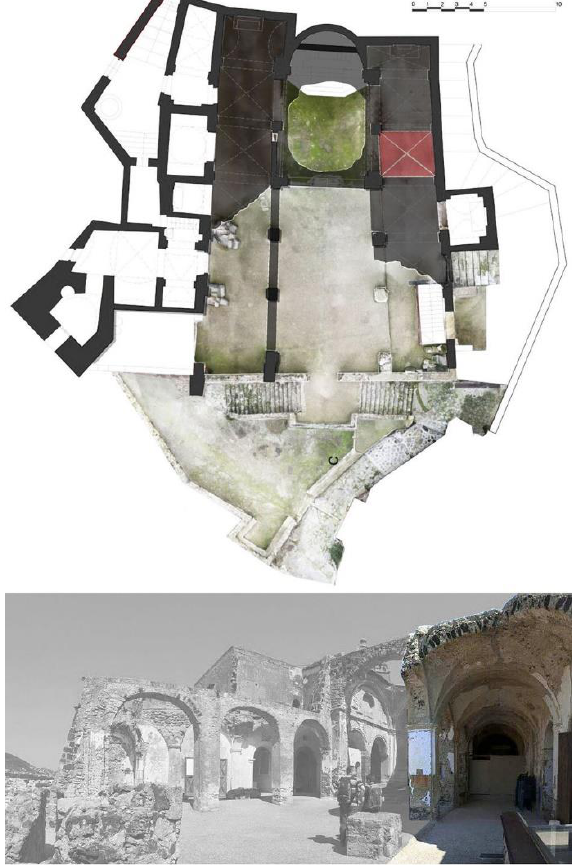
Figure 2. Identification of the vault case study belonging to the Cathedral original aisle (on the